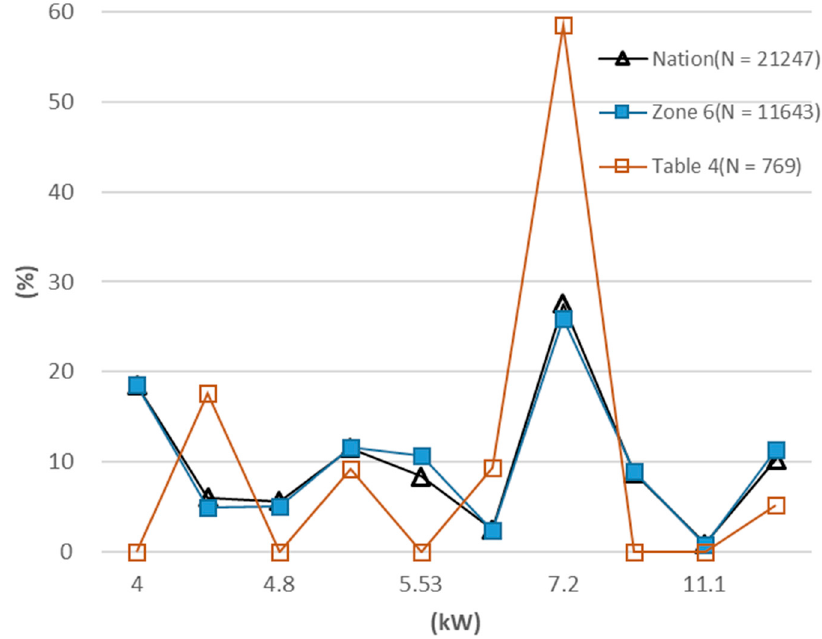
Figure 5. Capacity-based ratio of storage battery users.